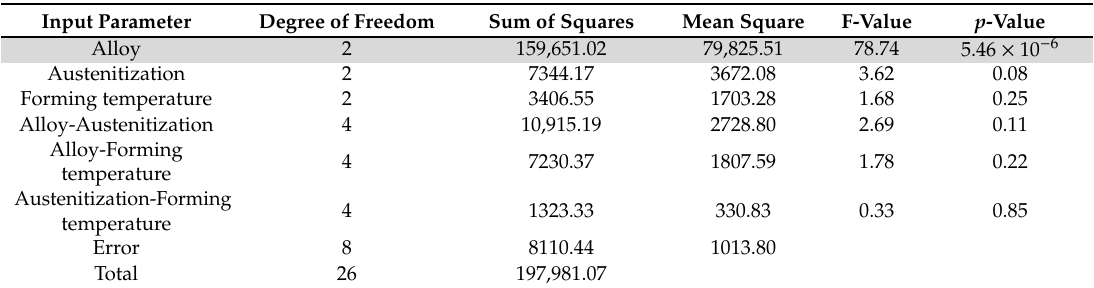
Table 5. ANOVA results for the resulting Vickers